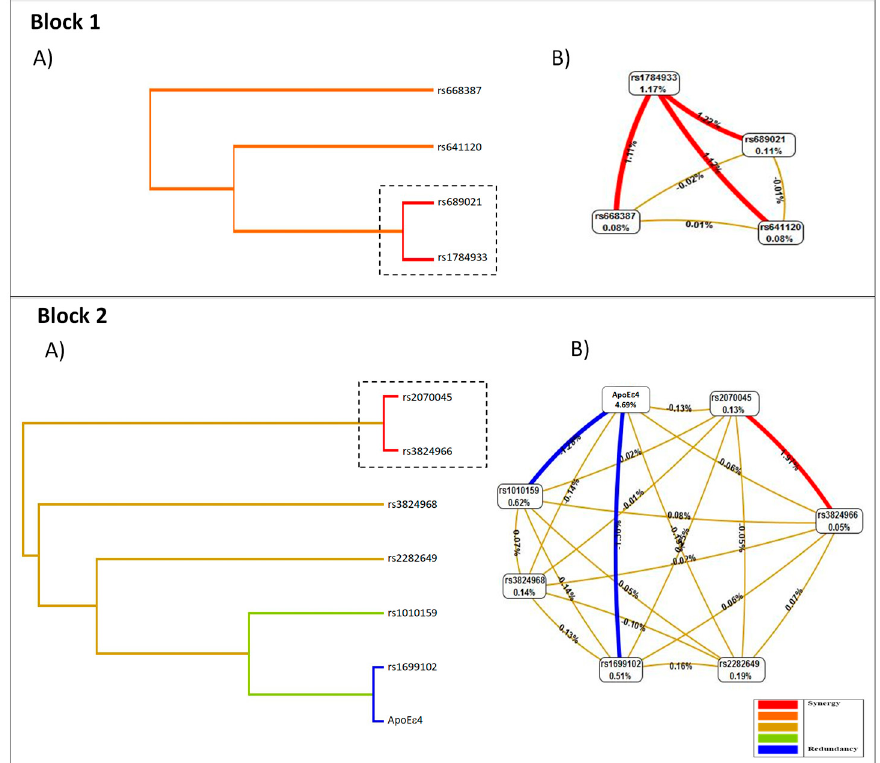
Figure 2. Interaction dendrogram and entropy-based interaction. Block 1 ( A ), the analysis interaction dendrogram, indicates a synergistic interaction between rs1784933 and rs689021 (dotted box) and to a lesser extent between the polymorphism rs1784933 with rs668387 and rs641120; Block 1 ( B ) entropy-based interaction graph shows the positive effects between these polymorphisms. Block 2 ( A ) the interaction dendrogram indicates a strong positive interaction between rs2070045 and rs3824966 (dotted box). ( B ) The entropy-based interaction graph confirmed strong positive effects between both polymorphisms. The models are adjusted for gender and age.